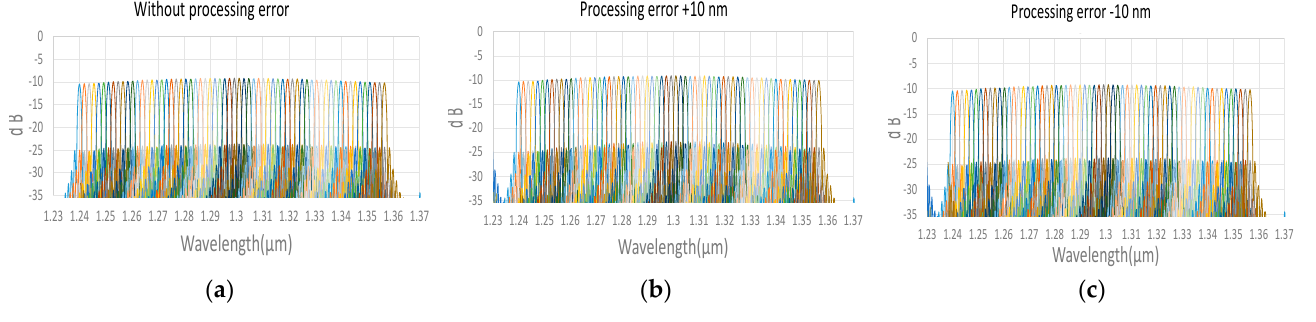
Figure 10. The simulated spectrum response for the EG ( a ) without the process length shift; ( b ) at 10 nm waveguide width shift; ( c ) at − 10 nm waveguide width variation. Different color lines represent individual wavelength output channels.